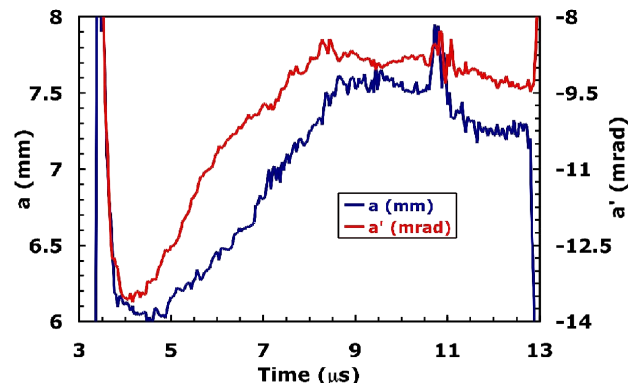
FIG. 5. (Color) Beam envelope 40 cm downstream of the exit of four solenoids as a function of time ( z (cid:5) 290 cm ).